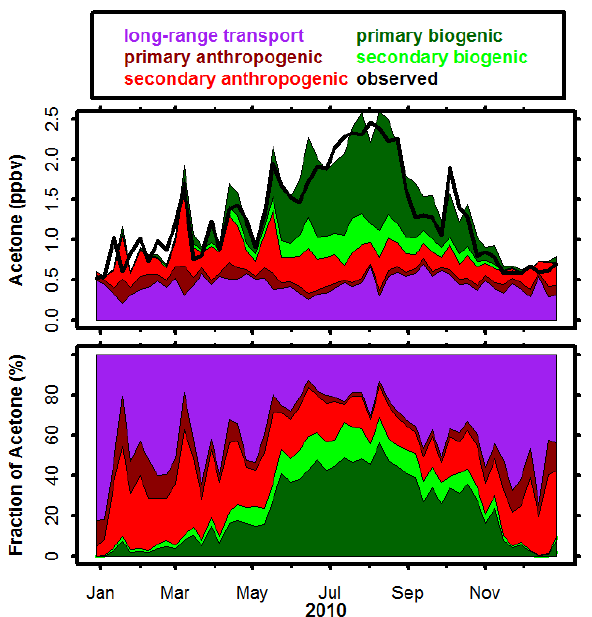
Fig. 6. Top panel: stack plot of the seasonal acetone mixing ratios Figure 6. Top panel: stack plot of the seasonal acetone mixing ratios from various sources in the 4 from various sources in the optimized GEOS-Chem simulation at optimized GEOS-Chem simulation at the KCMP tall tower. Also shown are the observed acetone 5 the KCMP tall tower. Also shown are the observed acetone mixing mixing ratios at the tall tower (black line). Bottom panel: Fractional contribution of these sources 6 ratios at the tall tower (black line). Bottom panel: fractional contri- to the total modeled acetone abundance in the optimized simulation. 7 bution of these sources to the total modeled acetone abundance in the optimized simulation.